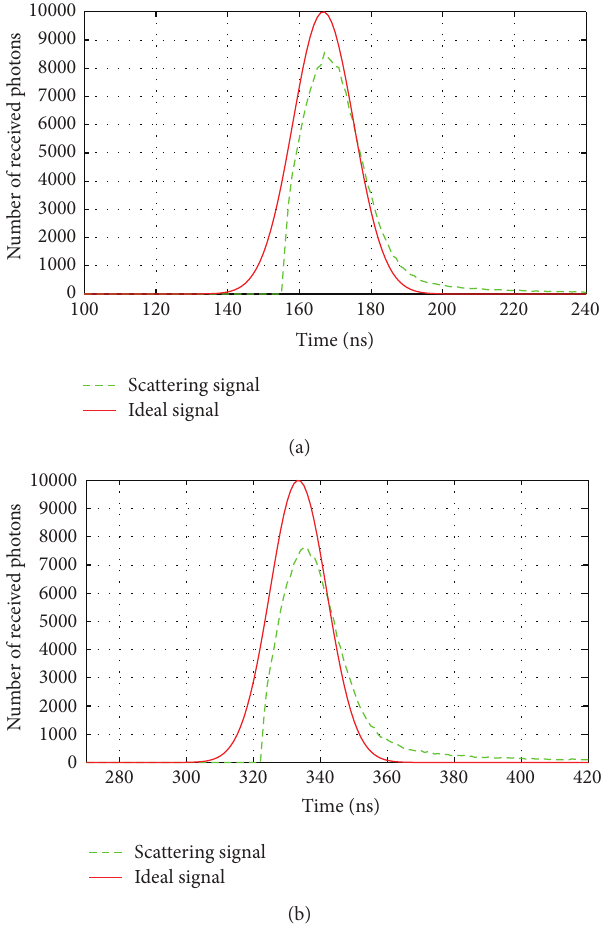
Figure 4: Temporal profiles of transmitted laser pulse for variable propagating distances ((a) 50m; (b) 100